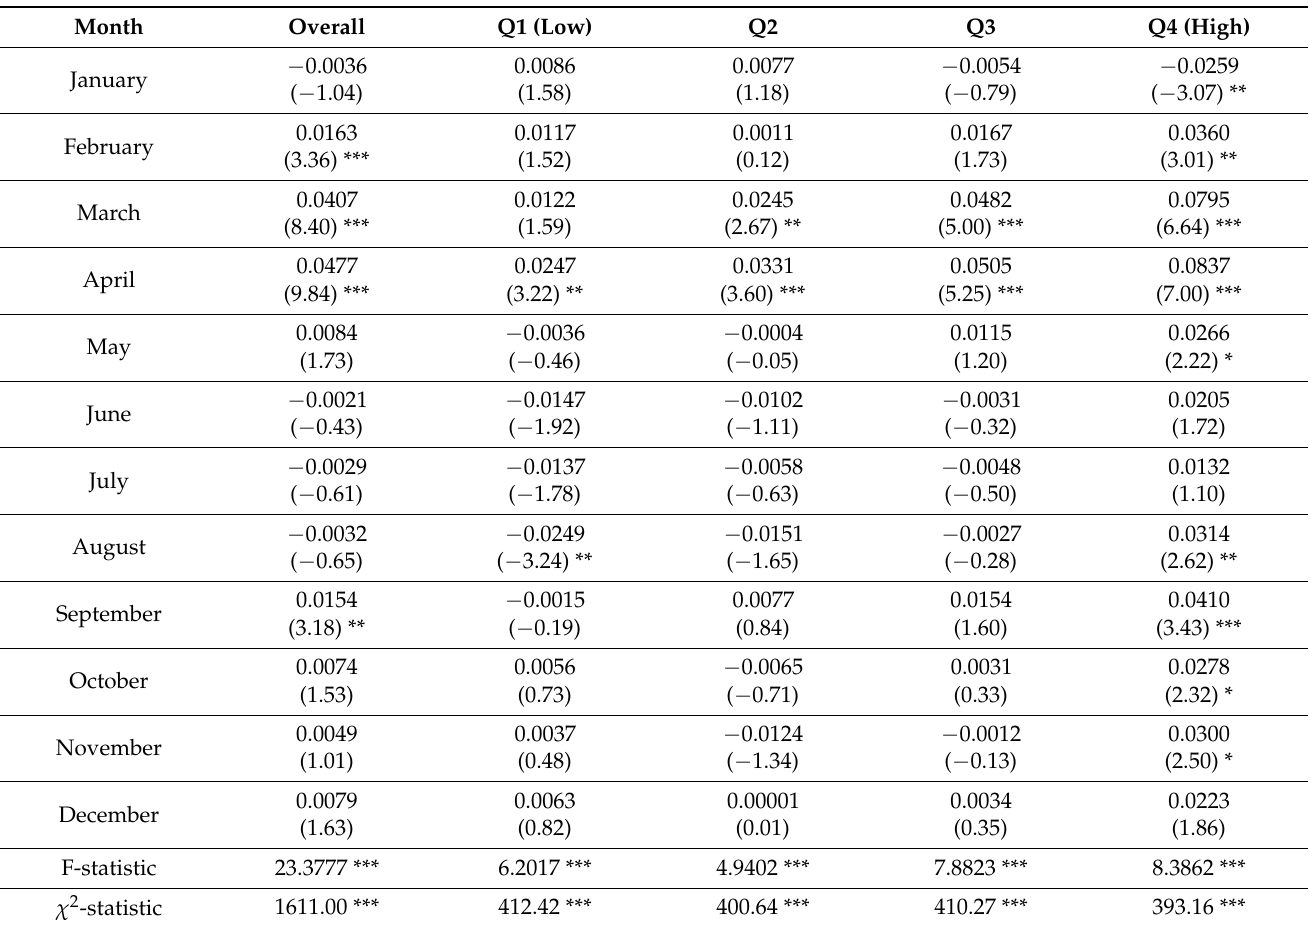
Table 2. Tests for monthly seasonal effects in raw returns with uncertainty quartiles. The table reports of OLS regressions for our sample of raw returns, which includes data from January 1997 through December 2018. The table reports estimates of seasonal dummy variables for the full sample as well as for quartiles based on the standard deviation of analysts’ forecasts scaled by price ( σ (FEPS)). t -statistics appear below each coefficient estimate with asterisks indicating statistical significance. The final two rows report F-tests and χ 2 -tests of the null hypothesis of no difference across months. *, **, and *** indicate significance at the 10%, 5%, and 1% level,